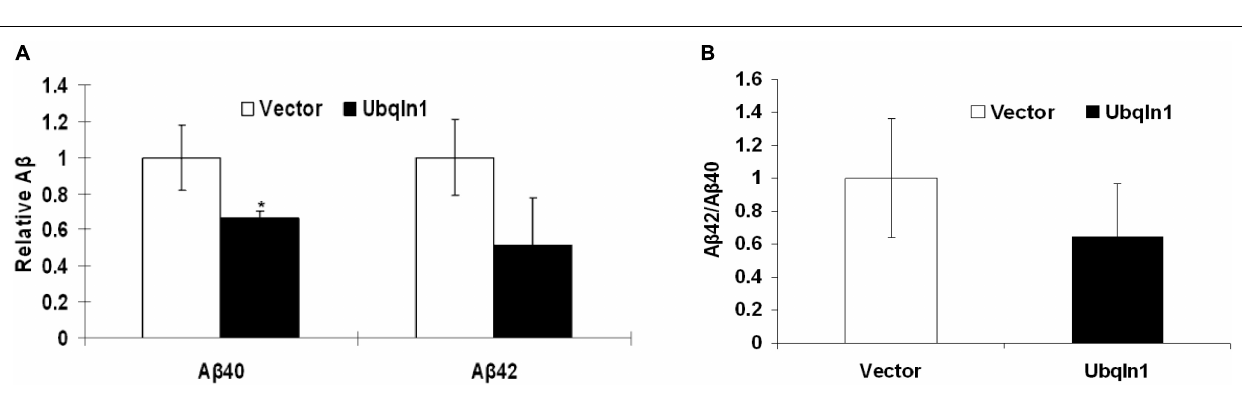
FIGURE 4 | Ubiquilin-1 overexpression decreases A β levels. The effects of ubiquilin-1 over-expression on A β levels were evaluated using naïve HEK293 cells which were transiently transfected with the ubiquilin-1 or empty vector plasmids. Conditioned media was prepared 48 h post transfection and utilized for A β assay by ELISA. (A) Ubiquilin-1 over-expression significantly decreased A β 40 (* p < 0.05) and showed a trend toward decreasing A β 42 levels and A β (42:40) ratios ( p > 0.05). (B) Ubiquilin-1 did not significantly change A β (42:40) ratios ( p >